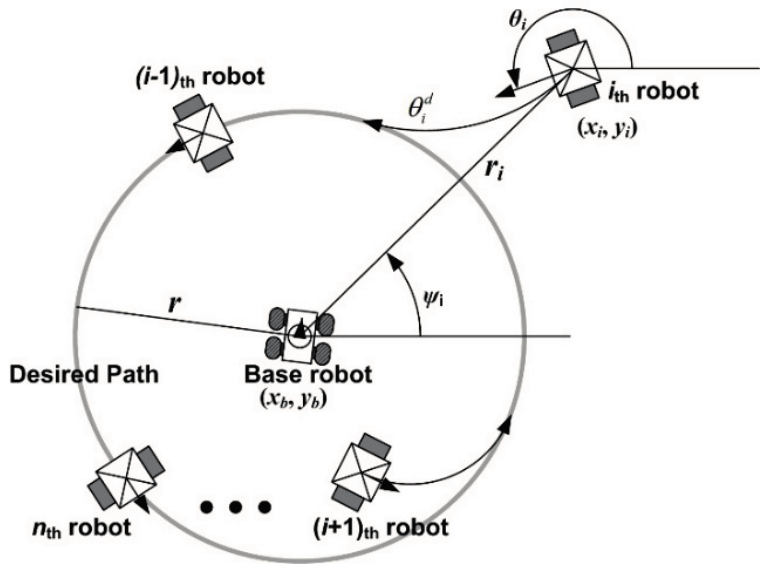
Figure 4. The motions of the child robots following the desired circular